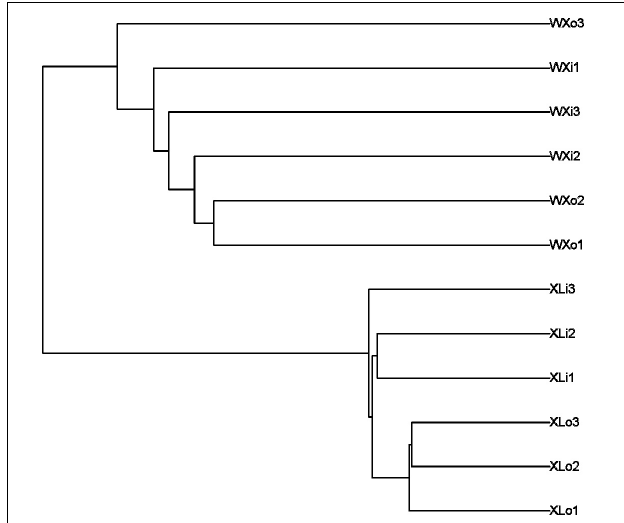
FIGURE 6 | The unweighted pair-group analysis (UPGMA) based on UniFrac distance for fungal communities of Doushen samples.